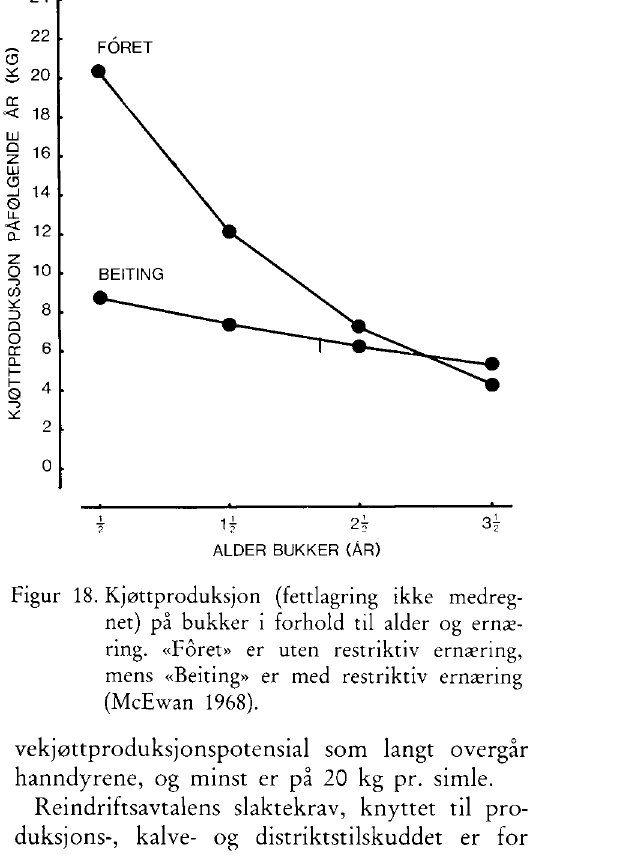
Tabell 3. Beregnet gjennomsnittsvekt og kalvekjøttproduksjonspotensial for tre simleflokker (SAMEBY 1, 2 og 3 i figur 16) med alternativ aldersstruktur (struktur «1975» og «1980» i figur 17). Middelvekt i simleflokkene utfra Total kalvekjøttproduksjon etter aldersspesifikk vekt i fig. 16 og fig. 10 av simleflokkene (300 simler) med gitt i fig. 17